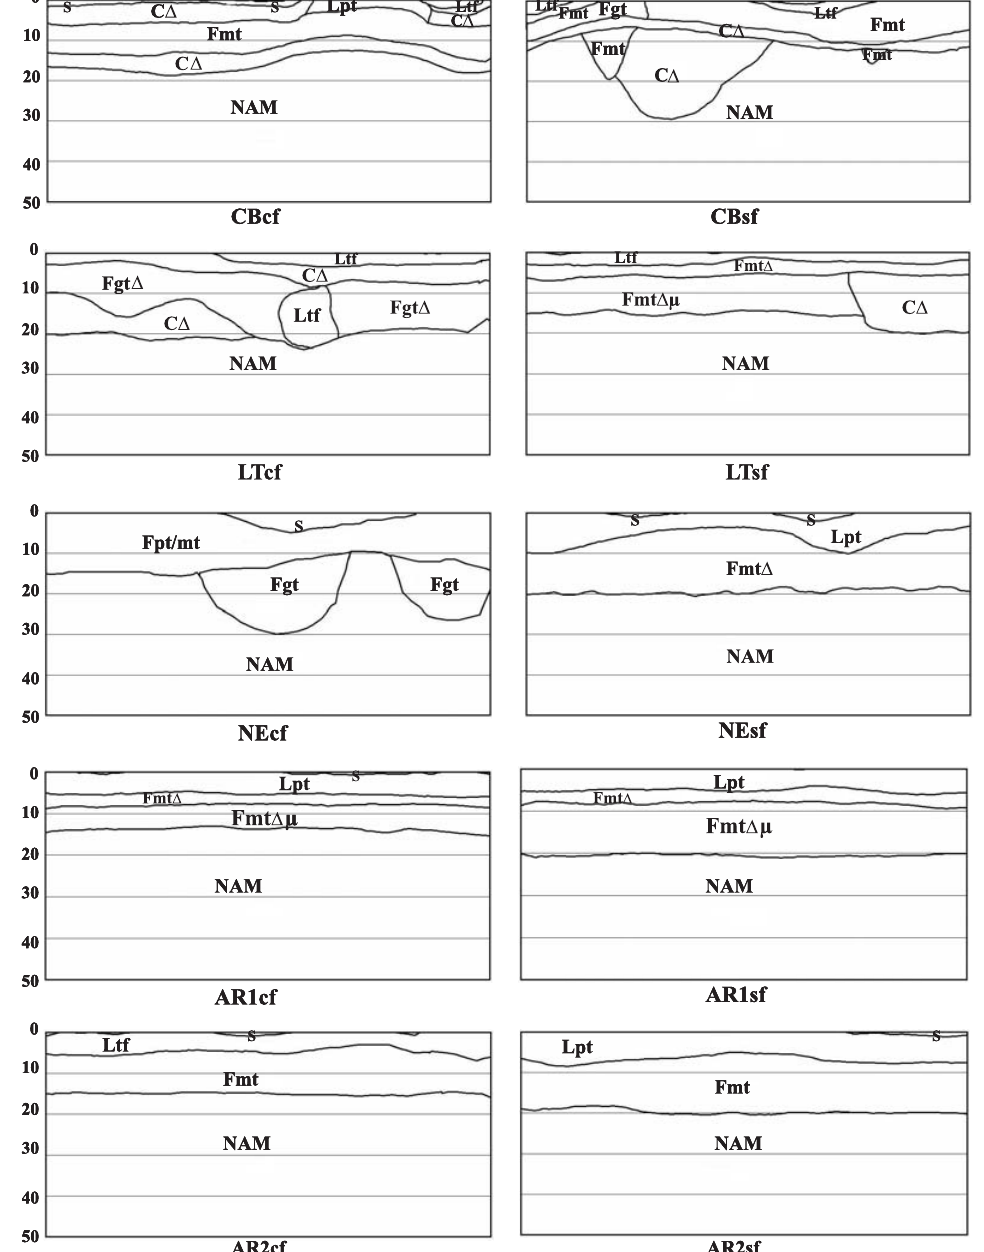
Figure 1. Digitalized crop profiles (profile width: 1.5 m; depth: 0.5 m; S: area adjusted by the software to offset profile surface irregularities; F or C: volume of cracked or continuous soil; ΔΔΔΔΔ or μ : compact clods or porous clods; pt, mt, gt: small, medium or large clods; tf: fine earth; L: powdery or loose soil; NAM: soil unaltered by cultivation; Soil: Cambissolo (CB) (Inceptisol), Latossolo (LT) (Oxisol), Neossolo (NE) (Entisol), Argissolo (AR1 and AR2) (Alfisol); cf: maize intercropped with jack bean, sf: sole